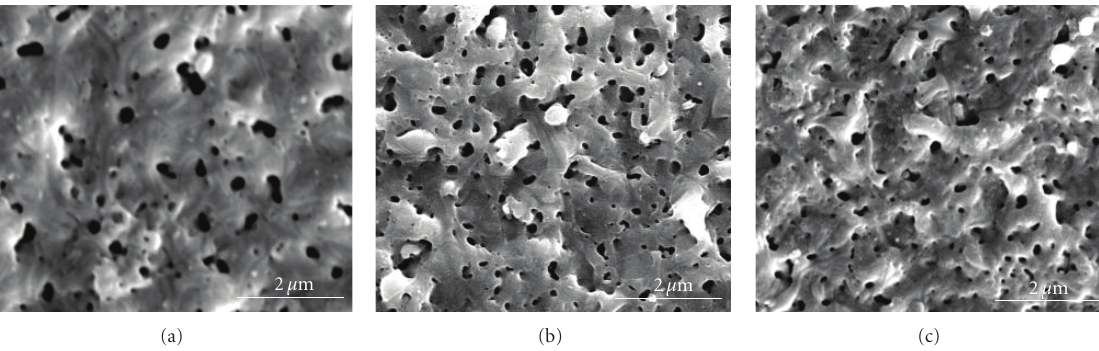
Figure 2: SEM images under di ff erent current densities: (a) 12A/dm 2 , (b) 14 A/dm 2 , and (c) 16A/dm 2 .